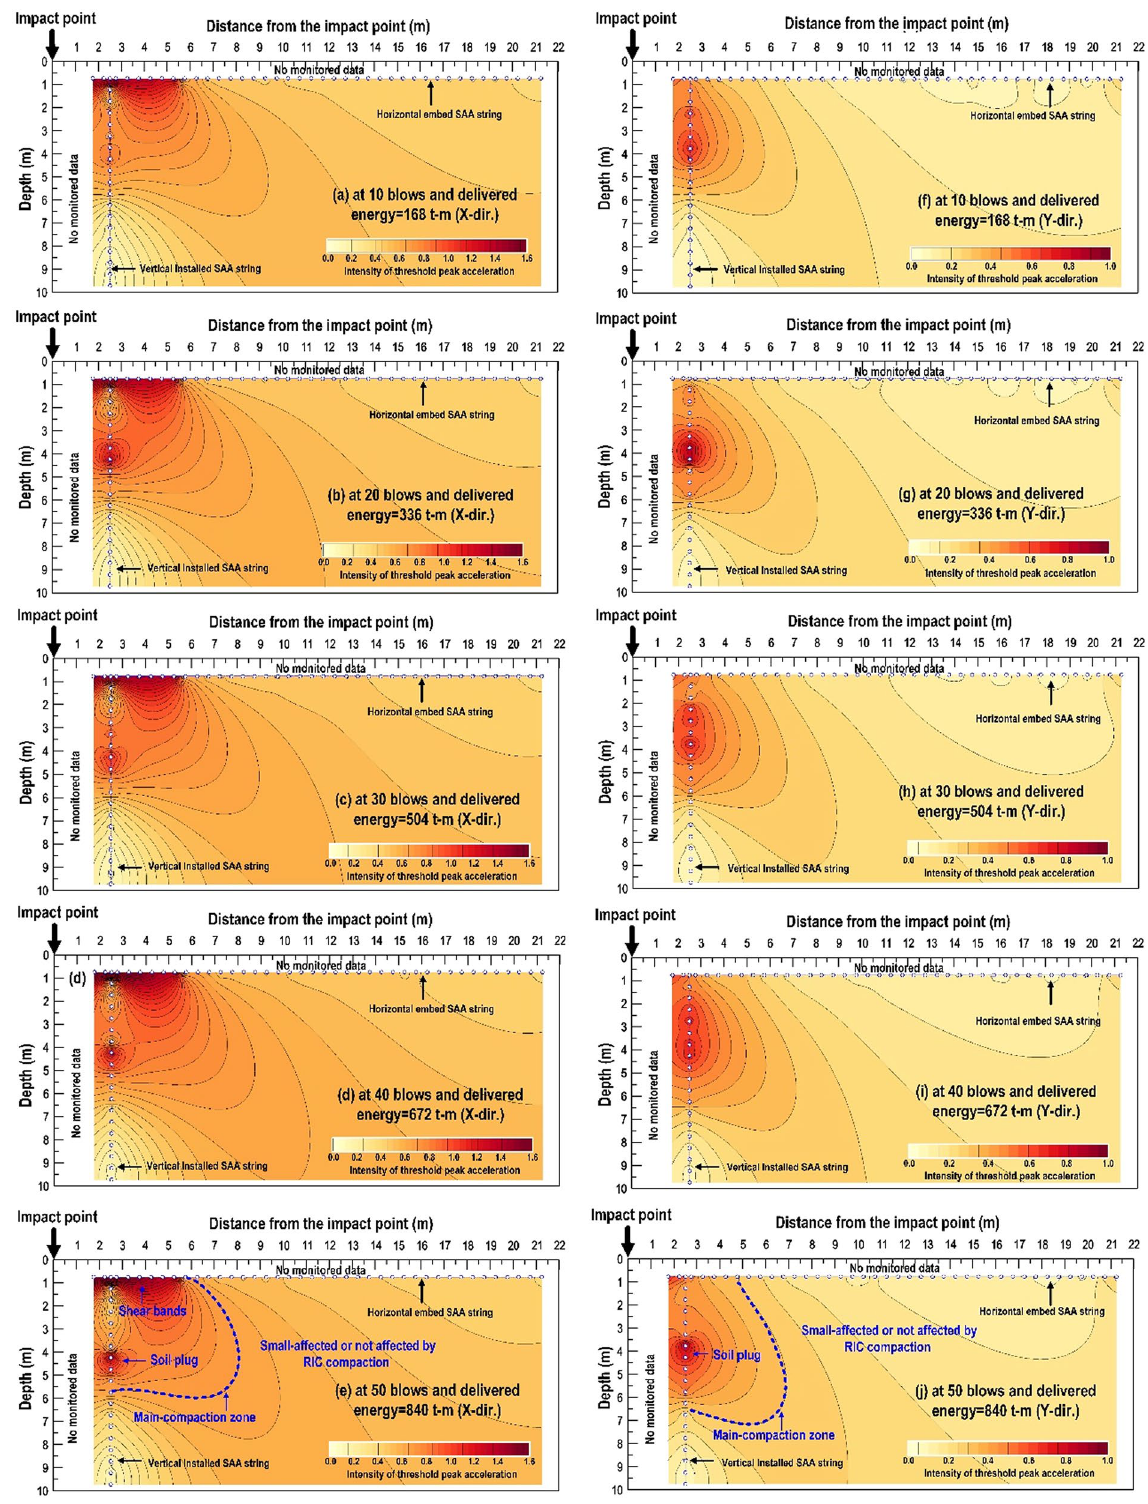
Figure 15. Spatial contour features of the threshold peak acceleration during RIC compaction at impact point 1–8: ( a – e ) X-direction contours after 10, 20, 30, 40, and 50 blows; ( f – j ) Y-direction contours after 10, 20, 30, 40, and 50